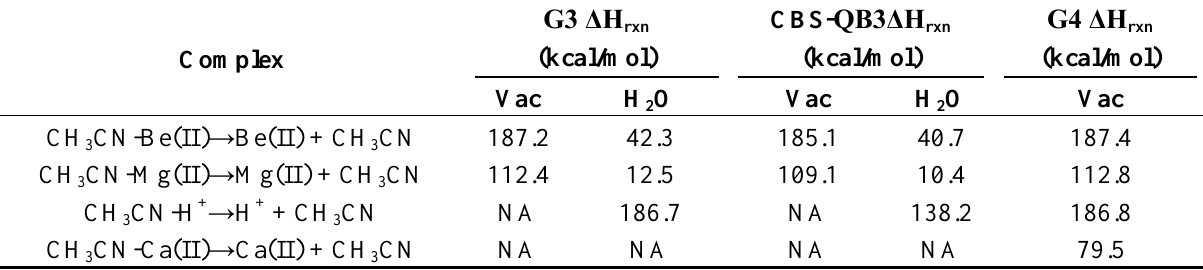
Table 10. G3, CBS-QB3 and G4 binding energies of acetonitrile complexes with Mg(II), Be(II) and H + in vacuum and water † .